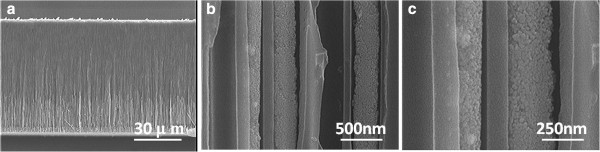
SEM micrographs of the (Bi,Sb)2 -xTe3 +x-based nanowires under different magnification ratio. (a) 1,000; (b) 50,000; and (c) 100,000. The bias voltage was set at -0.4 V, ton/toff was 0.2/0.6 s, and the electrolyte formula was 0.015 M Bi(NO3)3-5H2O, 0.005 M SbCl3, and 0.0075 M TeCl4.